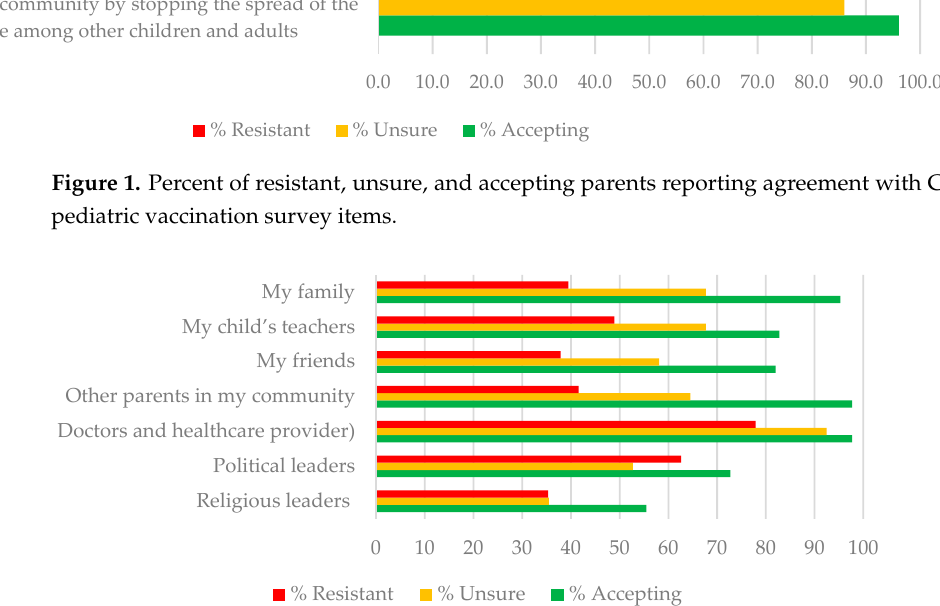
Figure 2. Percent of resistant, unsure, and accepting parents indicating community and family support for vaccinating children 1–4 years of age. Table 3. Bivariate correlations between intent to vaccinate, parental COVID-19 pediatric vaccination beliefs, community support, and demographic variables.